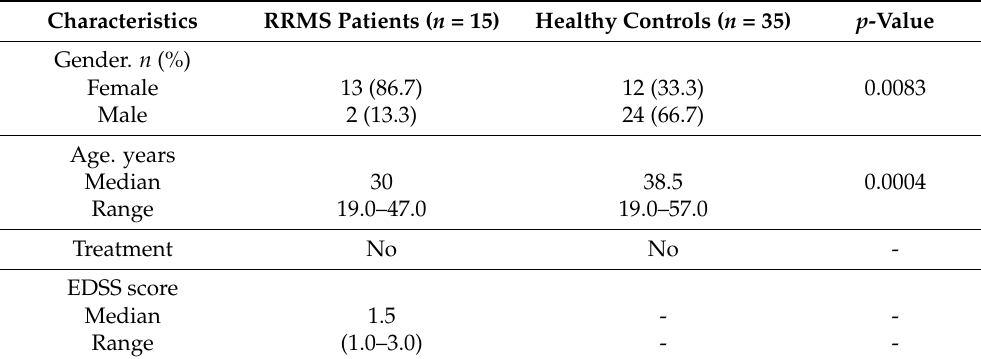
Table 2. Gender and age of healthy subjects and patients with RRMS characteristics. Baseline clinical